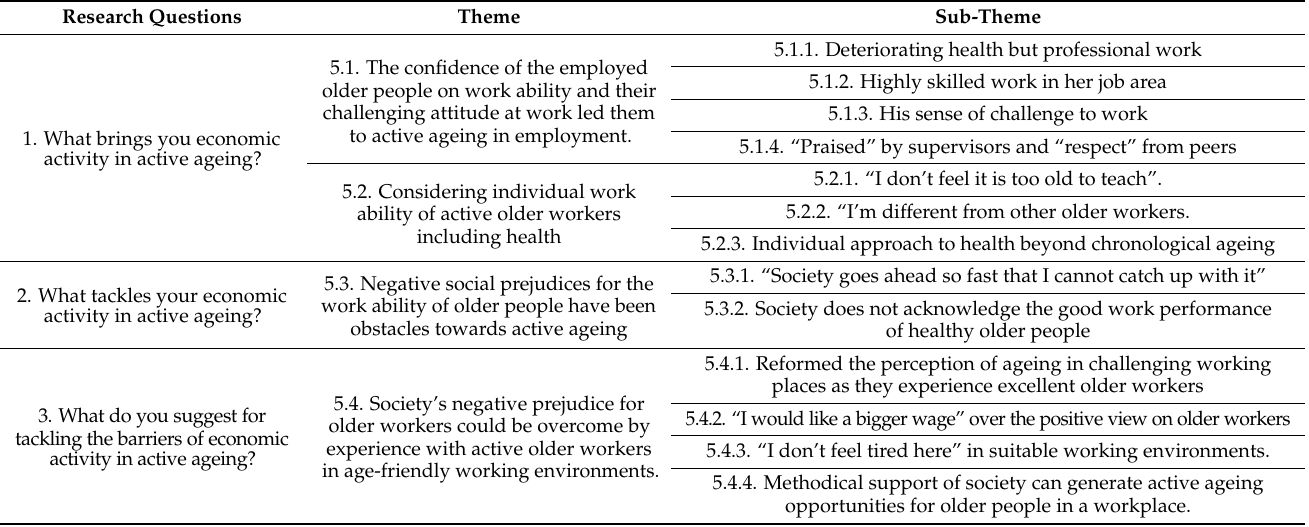
Table 2. Research findings in